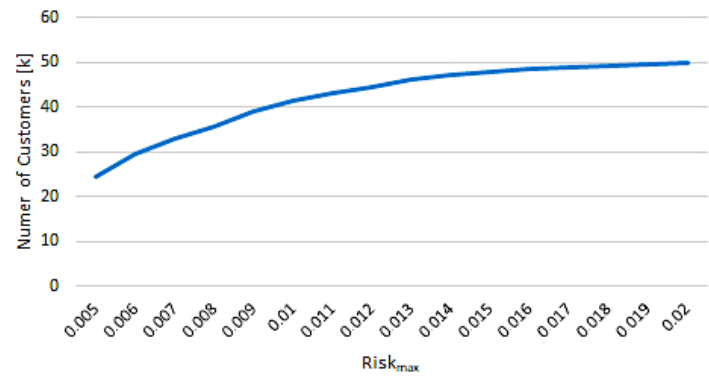
Figure 5. Customers with at least 1 transaction